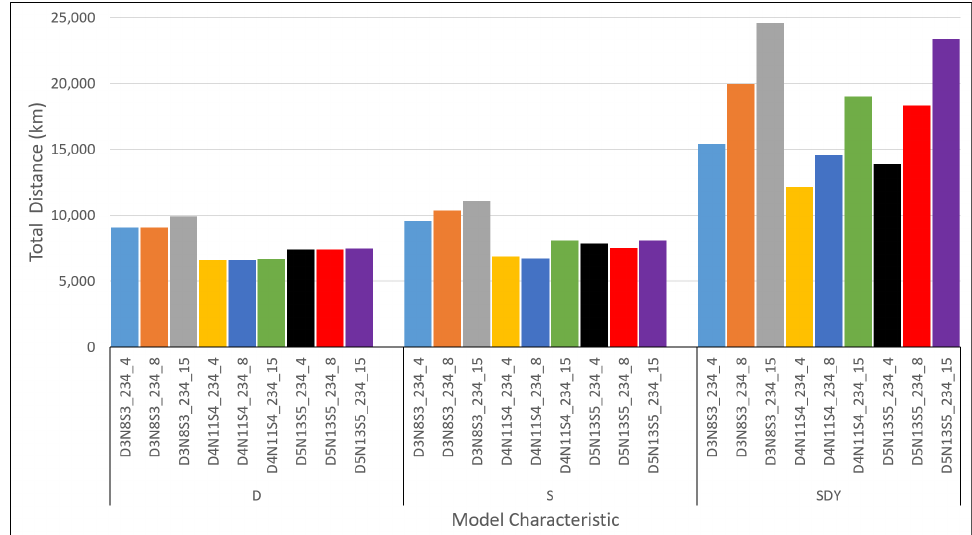
Figure A15. Total Distance Travelled for Maximum Road Capacity Setting ( 2,3,4 ) in Online and Offline Computation for all Instances grouped by Model Characteristic.